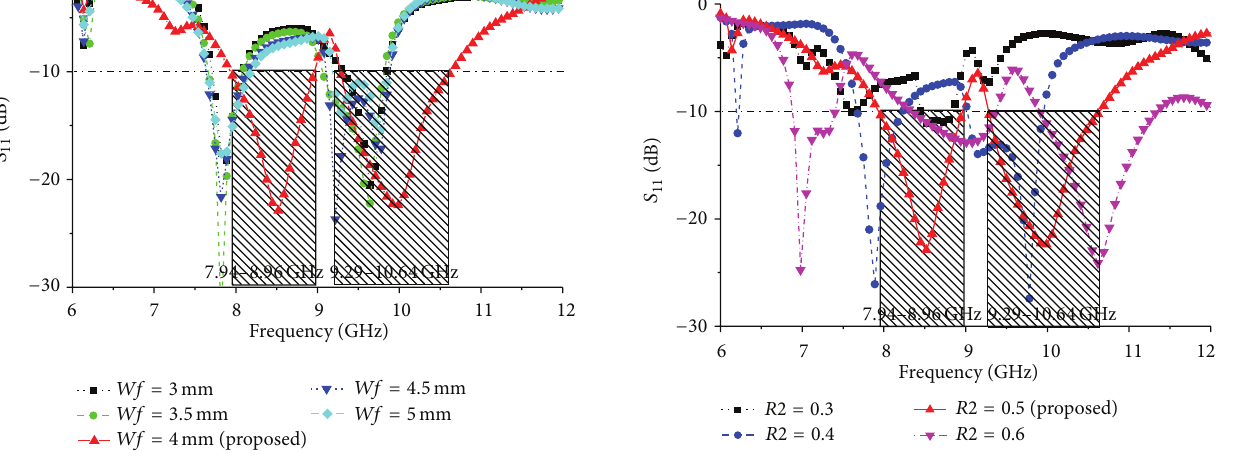
Figure 8: Simulated return loss for the different values of ground plane elliptical slot ratio 𝑅2